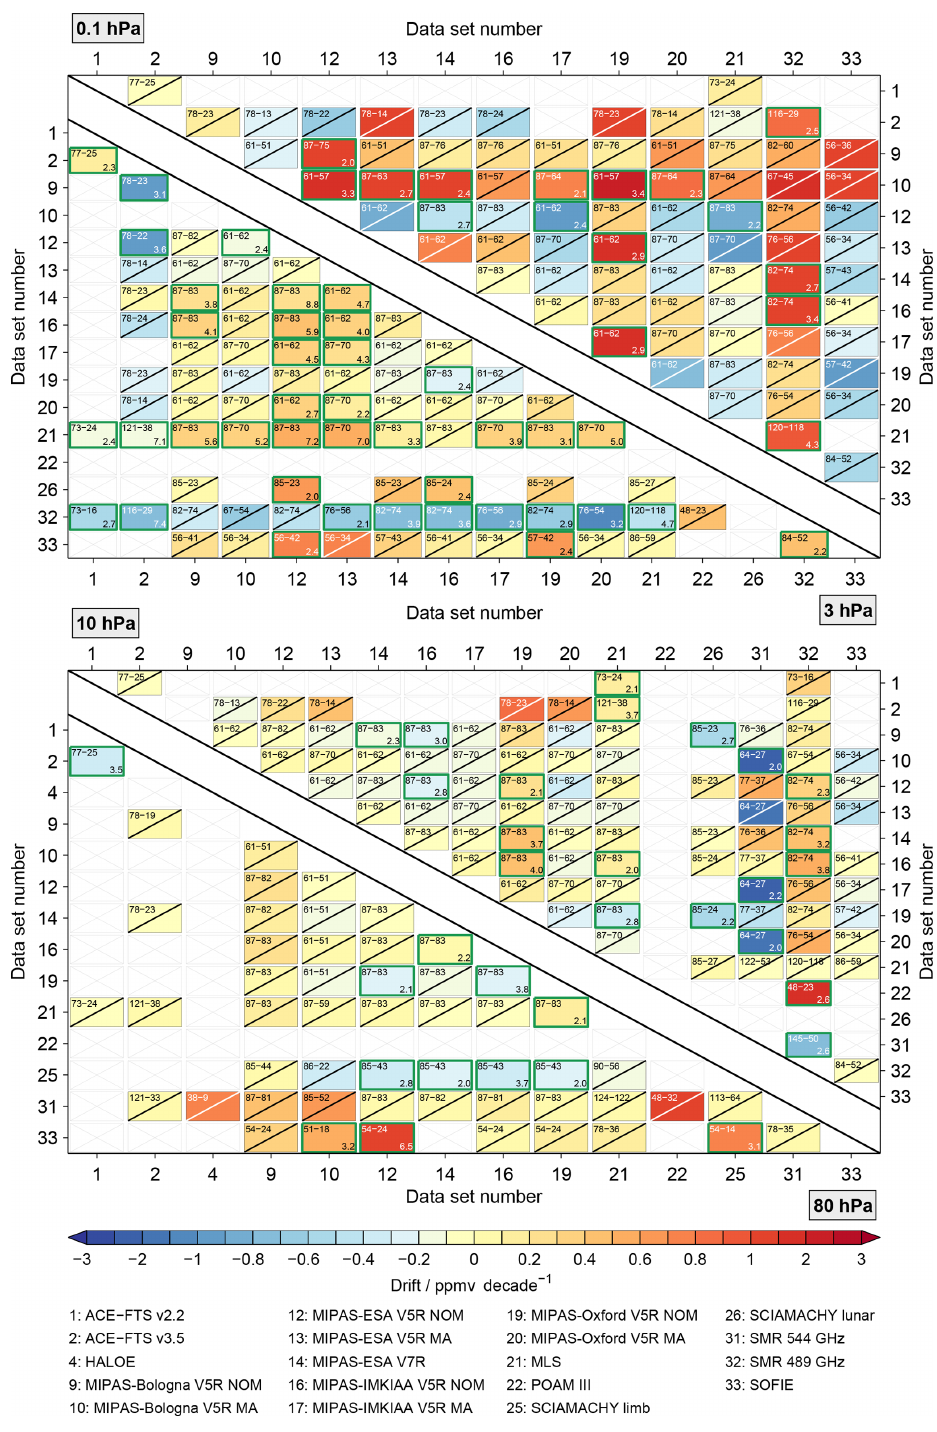
Figure 15. Drifts between the different data sets in the latitude band between 80 and 70 ◦ S at 80, 10, 3 and 0.1hPa. The drift estimates are based on the difference time series between the data sets given at the x axis and the data sets given at the y axis. Data sets are only shown if they yield any result at a given altitude. Besides the colour-coded drift estimates the result boxes contain additional information. In the upper left, the overlap period of the two data sets is given first. The second number indicates how many months the data sets actually overlap. If a drift is not significant at the 2 σ uncertainty level this is marked by a slant. In contrast, if a drift is significant this is marked by a green frame and the significance level is noted in the lower-right